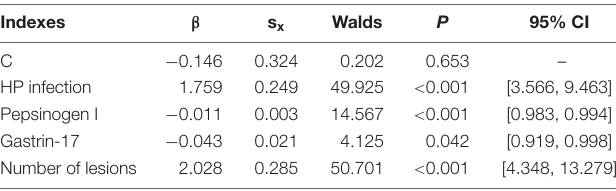
TABLE 2 | The detail information of multiple factors logistic regression analysis of the risk factors for the onset of intestinal metaplasia or dysplasia in CAG patients.